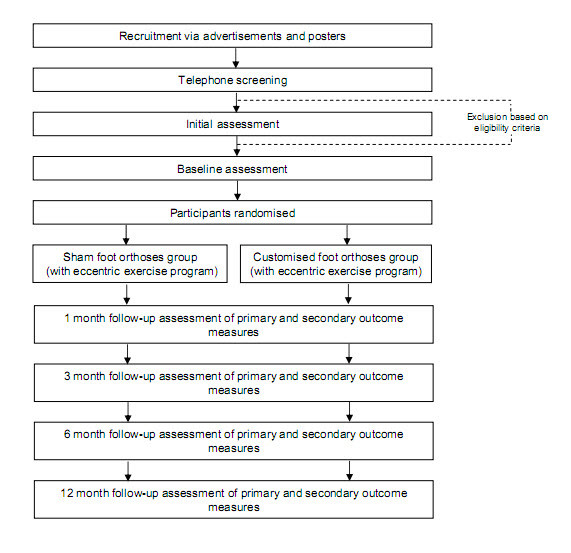
Design of study.